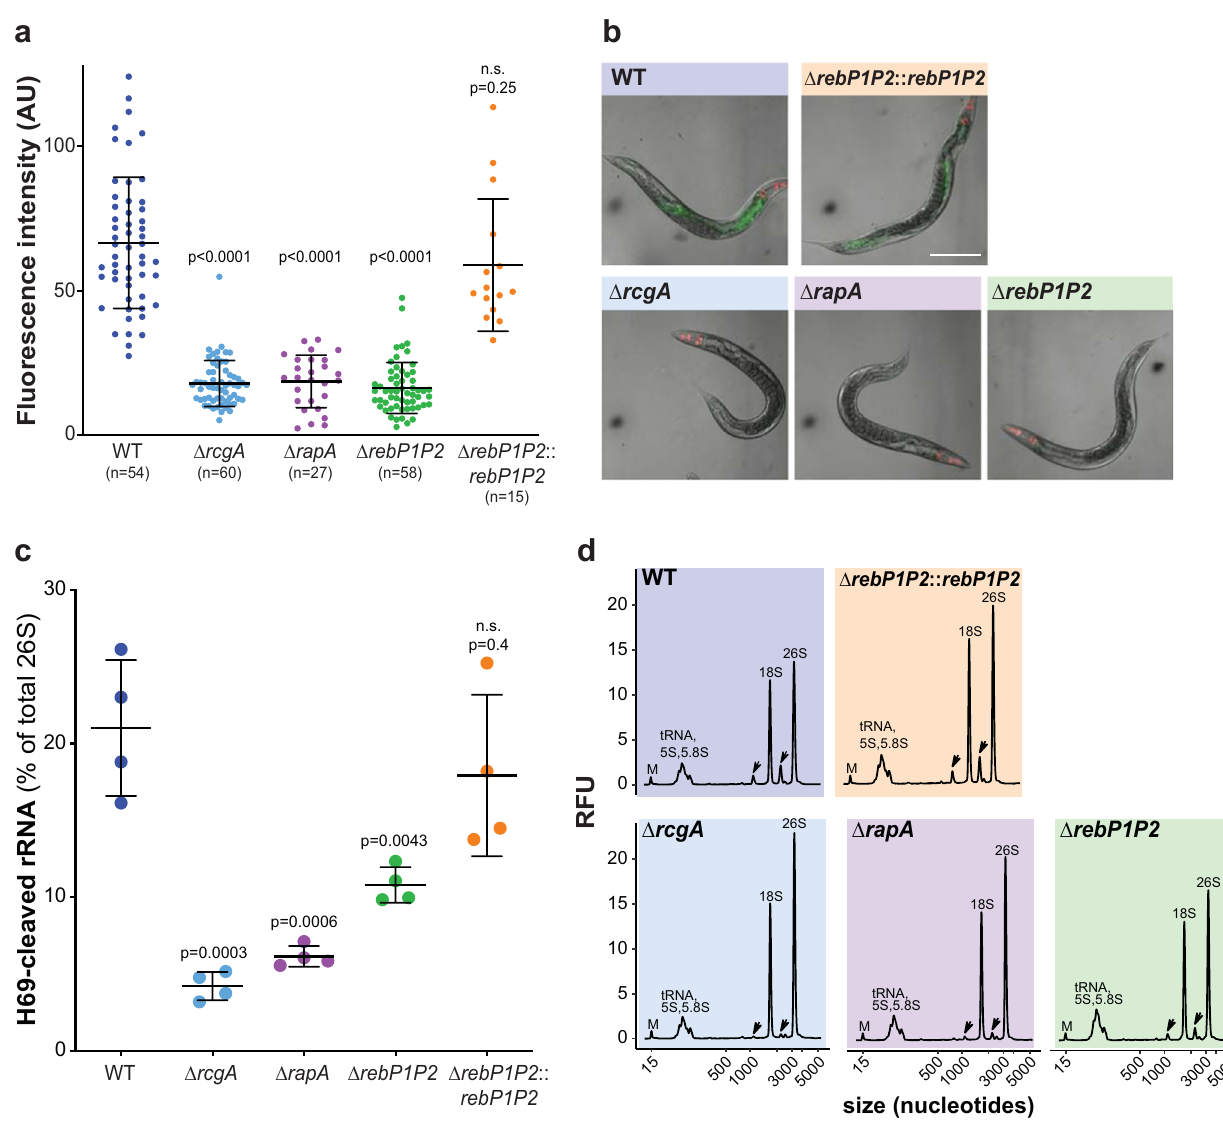
Fig. 7 Genes in the PA14 reb cluster contribute to translational inhibition and ribosome cleavage during C. elegans infection. a Quanti fi cation of fl uorescence intensity of irg-1 :: gfp in the images obtained in b using ImageJ/Fiji. p values indicated were calculated using unpaired, two-tailed t-tests. n ≥ 15 biological replicates from four experiments. b Images of C. elegans containing the irg-1 :: gfp transgene fed P. aeruginosa with the indicated genotypes for 12 h. Each panel shows fl uorescence overlayed with Nomarski. Images are representative of ≥ 15 replicates from four experiments. Scale bar is 100 µ m. c H69 cleavage levels (as percentage of the total 26S rRNA) in adult worms exposed to the PA14 wild type (WT) or the indicated mutants. p values indicated were calculated using unpaired, two-tailed t-tests. n = 4 biological replicates from two experiments. Data are presented as mean values± SD. d Total RNA pro fi le of adult worms exposed for 24 h to the indicated P. aeruginosa strains. Black arrows denote the H69-cleaved rRNA fragments. RFU relative fl uorescence units; “ M ” indicates a 15-nt marker used in the electrophoretic separation